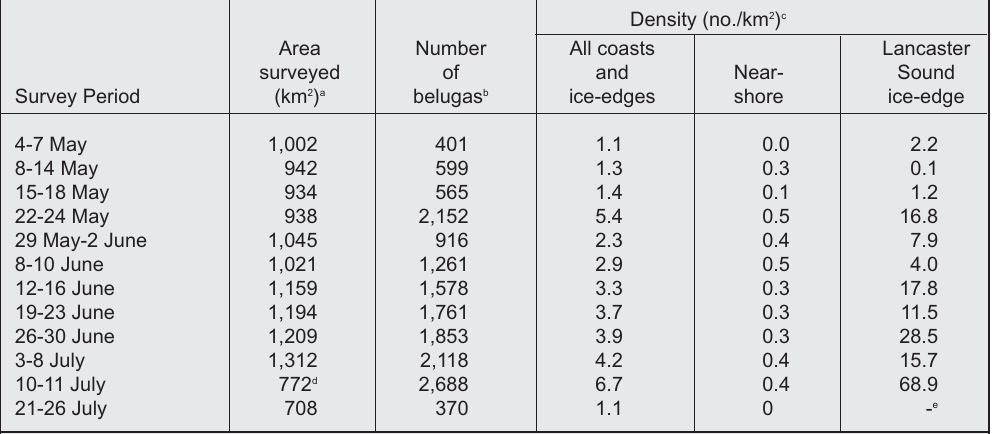
Table 2 . Numbers and densities of belugas recorded during aerial surveys of northwestern Baffin Bay and eastern Lancaster Sound, 4 May-26 July 1978. The survey route is the heavi- ly dotted line on Fig. 1 (see also Fig.